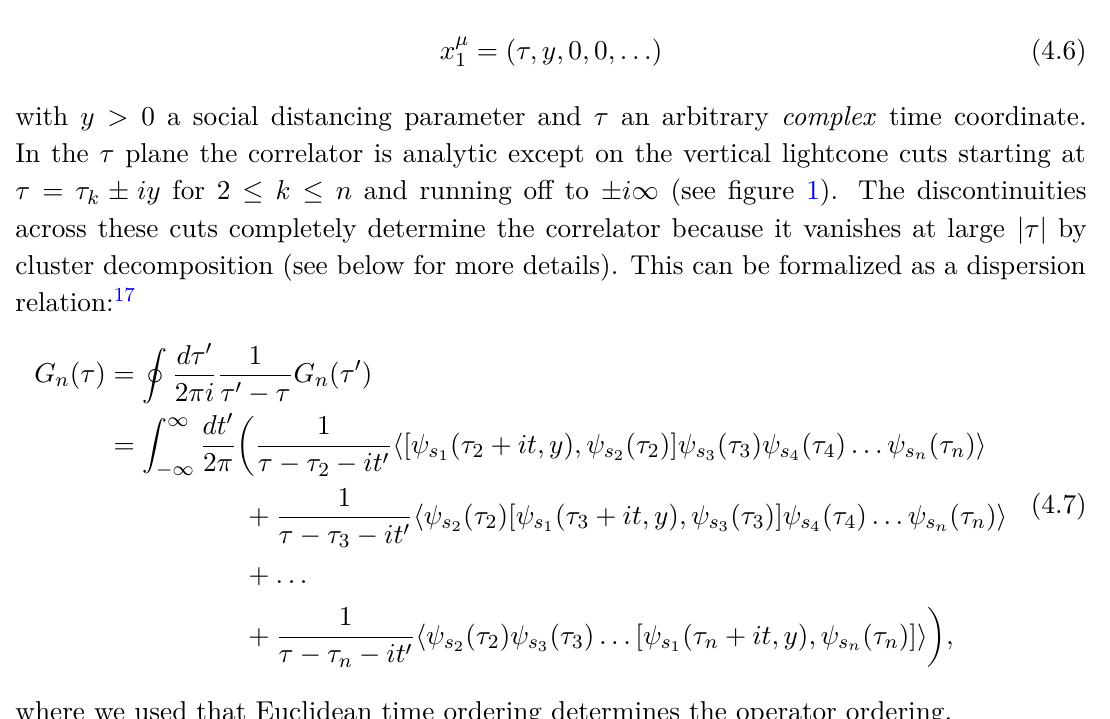
Figure 1 . Left: operators ψ s ( k ≥ 2) are inserted along the Euclidean time (Re τ ) axis. k Lorentzian time is along the imaginary- τ axis. The lightcone of ψ s ψ s is off the line and its time component τ is complex in general. Right: lightcone branch cuts on 1 the complex- τ